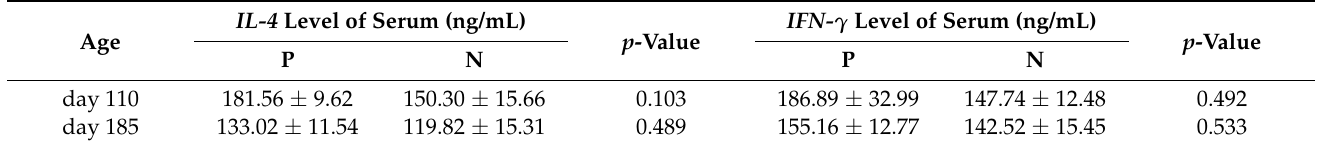
Table 2. The serum of the IL-4 and IFN- γ levels in antibody-positive and antibody-negative pigs at different periods.